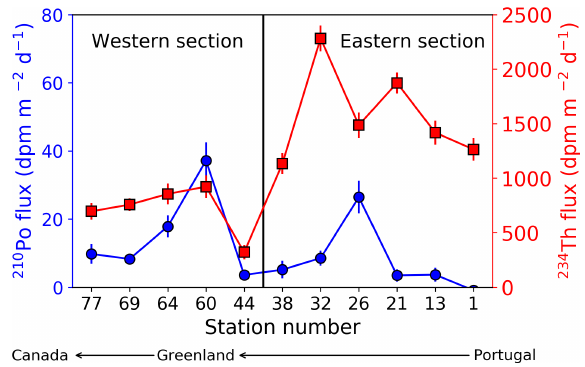
Figure 9. Sinking fluxes of 210 Po (blue circles) and 234 Th (red squares) integrated to the depth at which 234 Th activity returned to equilibrium with 238 U activity (ThEq), assuming steady state and negligible physical transport along the GA01 transect. Note that the stations are plotted from west to east, and the transect was sepa- rated into the western (stations 44–77) and eastern (stations 1–38)